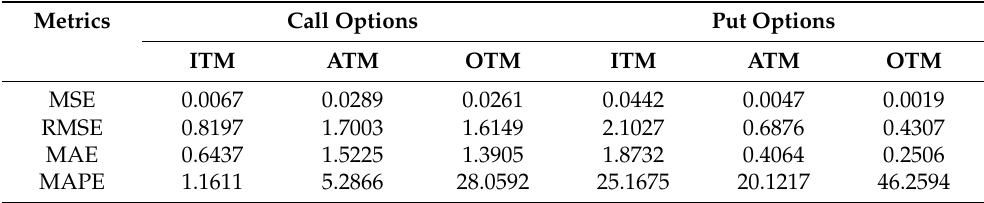
Table 5. Pricing error of LSTM without realized skewness. Metrics